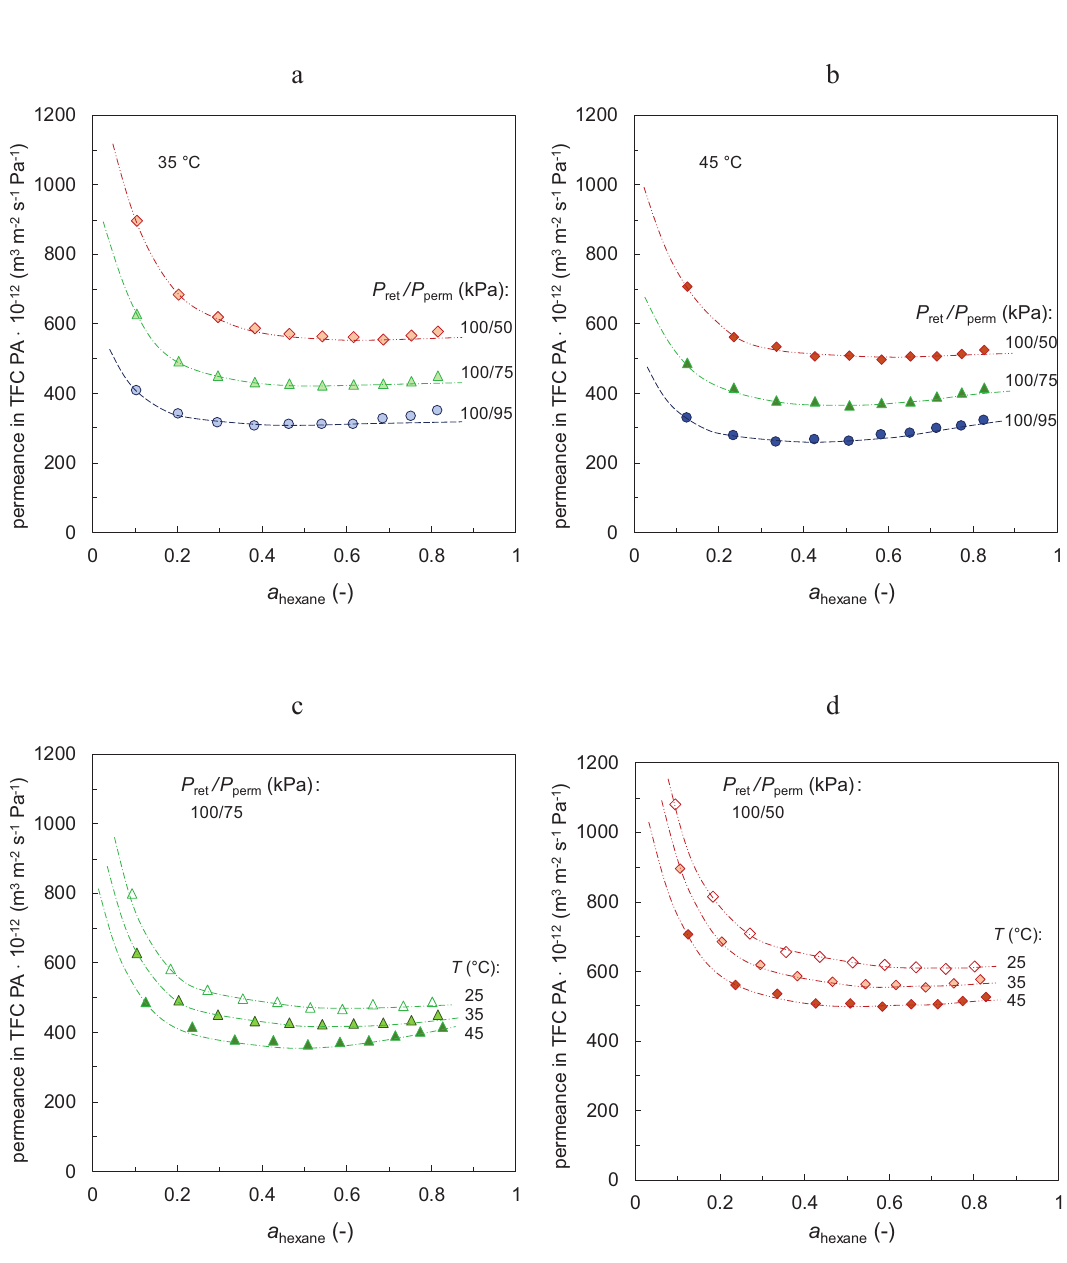
Fig. S5 – Hexane permeance in TFC PA (Toray) membrane: activity dependence at three different trans-membrane pressures at a) 35 °C and b) 45 °C, activity dependence at three temperatures at trans-membrane pressure c) 25 kPa and d) 50 kPa; The lines are intended as a guide to the eye.